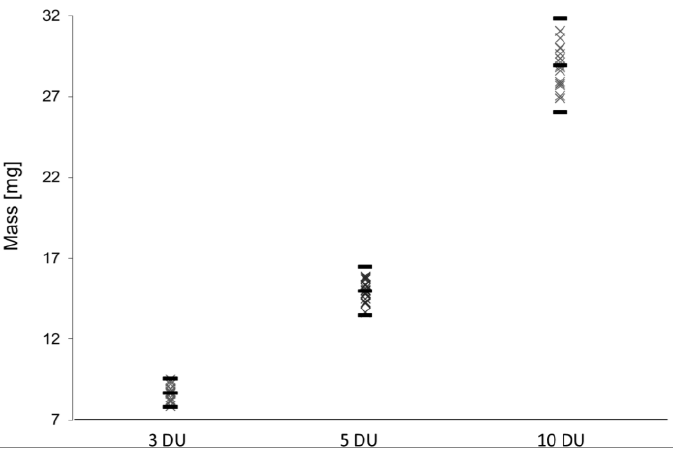
Figure 3. Masses of individually divided doses of the effervescent formulation using the SDP (d = 3.0 mm; 3, 5 und 10 dosage units, n = 20), arithmetic mean ± 10% according to Ph.Eur.